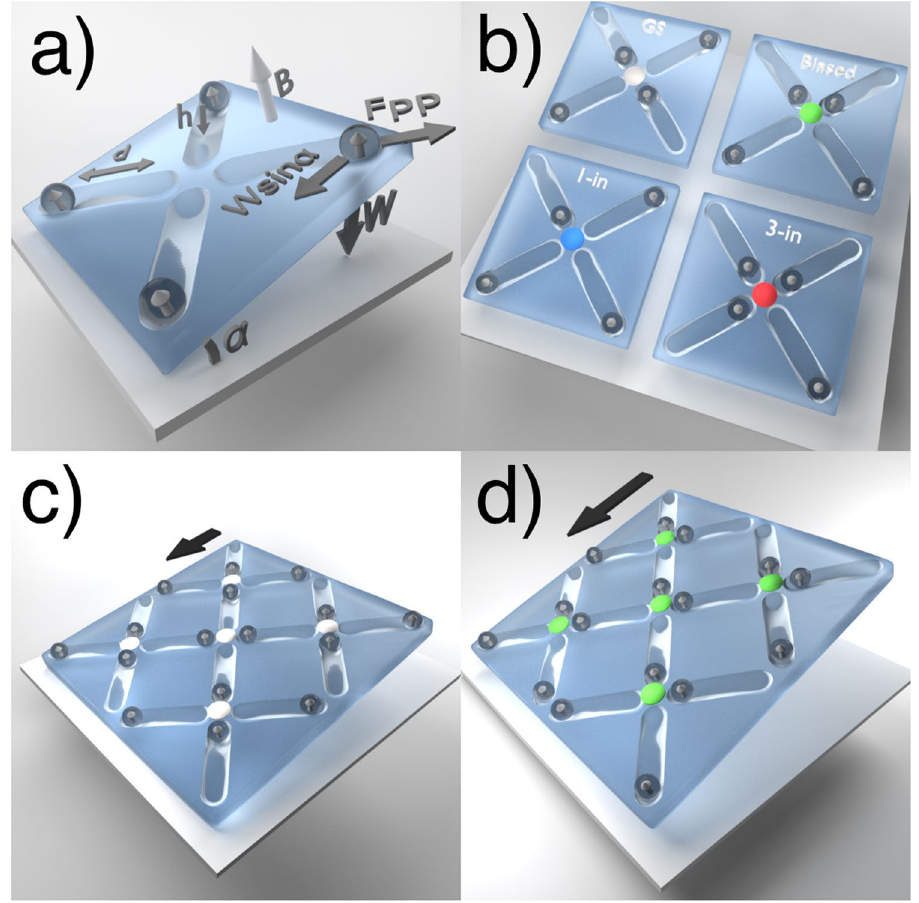
Figure 1. Schematics of the system. ( a ) A single vertex is surrounded by four double-well pinning sites. Labels indicate the distance d between the minima, the barrier height h , the biasing tilt angle α , the magnetic field B , the magnetization m it induces in the paramagnetic particles, and the pairwise magnetic repulsive forces F pp acting in the sample plane. W is the weight of the particle, and the tangential component W sin( α ) serves as a biasing force. ( b ) Illustration of four possible vertex arrangements with a nonphysical color placed at the vertex center to indicate the vertex type. Ground state (GS, gray), biased state (green), 1-in state (blue), and 3-in state (red). ( c ) The unbiased ground state (gray) in a small segment of the sample for a small bias α . ( d ) The biased ground state (green) in a small segment of the sample for a large bias α